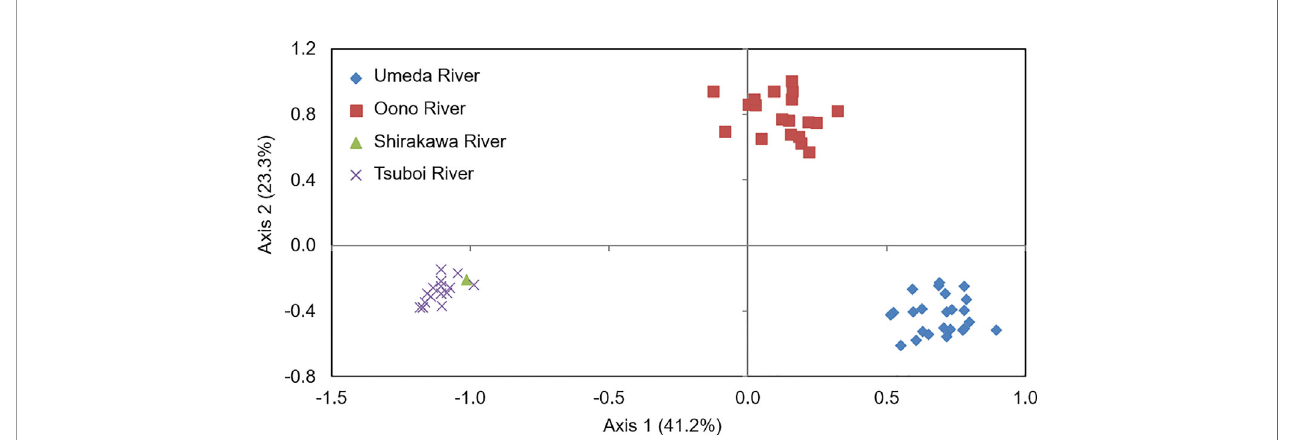
FIGURE 3 | Results of a principal coordinate analysis (PCoA) of Spartina alterni fl ora local populations in Japan based on co-dominant genotypic distances. Axis 1 and Axis 2 account for 41.2% and 23.3% of the variance, respectively. Symbols are as follows: rhomboid, populations in Umeda River (Aichi); square, in Oono River (southern Kumamoto); triangle, in Shirakawa River (northern Kumamoto); cross, in Tsuboi River (northern Kumamoto).